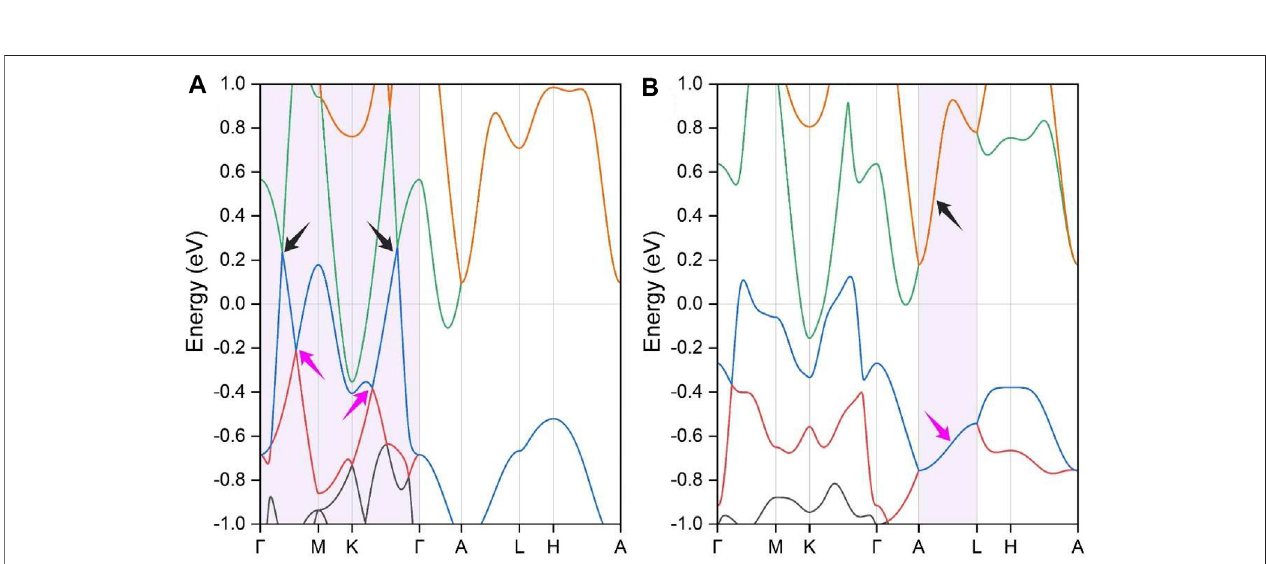
FIGURE2| ThecalculatedelectronicbandstructuresoftheBaAgBimaterial (A) withouttheSOCeffectand (B) withtheSOCeffect.Thetopologicalbandcrossing areas are indicated by the arrows. In this fi gure, each band is highlighted by different colors.